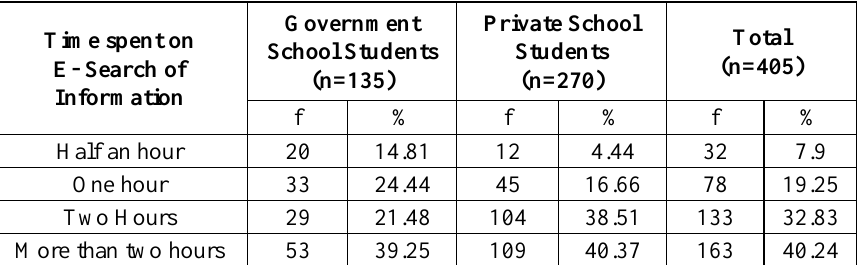
Table 6- Time Spent on E- Search of Information on Daily Basis